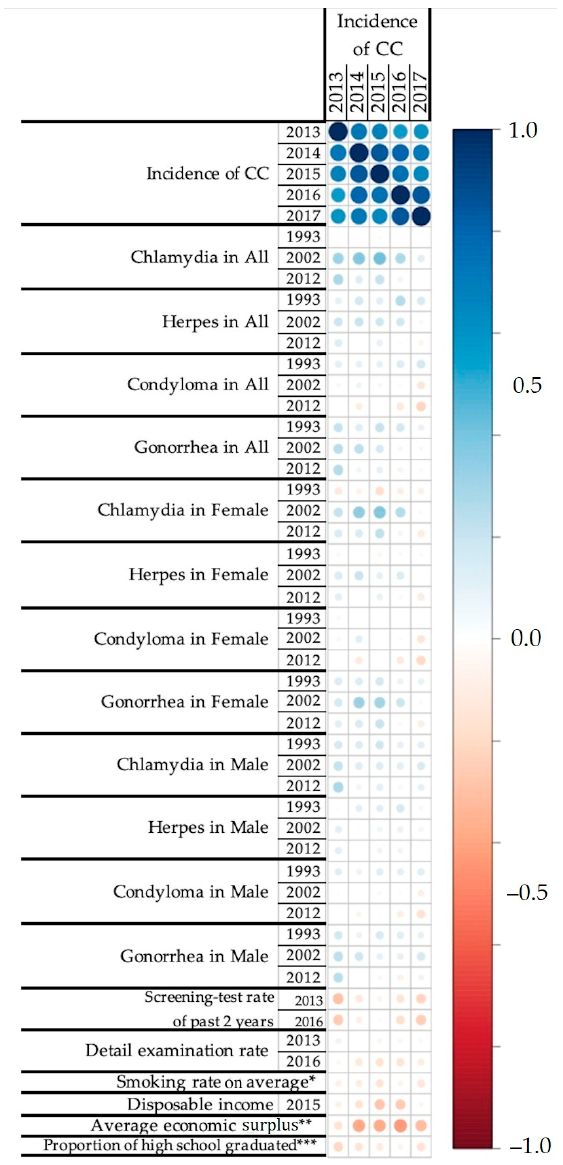
Figure 1. Associations between the incidence rate of CC and the possible risk factors. The blue circle represents a positive correlation between the variables (from 0.0 to 1.0), and the red circle represents a negative correlation between the variables (from –1.0 to 0.0). The darker color shows the stronger correlation. The figure includes the incidence rates of four types of STDs (i.e., Chlamydia, Herpes, Condyloma, and Gonorrhea), two types of economic status (disposable income and average economic surplus), smoking rate, two types of medical examination rates (screening test rate and detailed examination rate), and proportion of the people whose final education level is equal to or under high school graduate. The four digits at the end of each variable name show the year in which the data were reported (e.g., 2013 means the data reported in the year 2013). * The average value of smoking rate among the records in 2001, 2004, 2007, 2010, and 2013. ** The difference between disposable income and average expenditure in 2014. *** Proportion of the people whose final education level is equal to or under high school graduate.